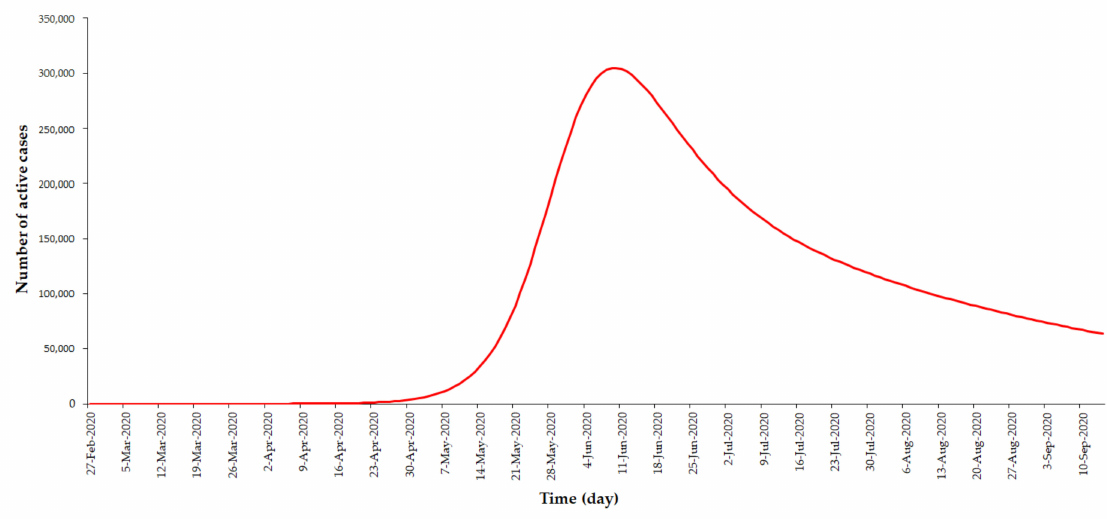
Figure 4. Model simulation of number of COVID-19 active cases by day, with only tracing, isolation, and quarantine measures, but without the MCO, February to September 2020, Malaysia ( ζ =